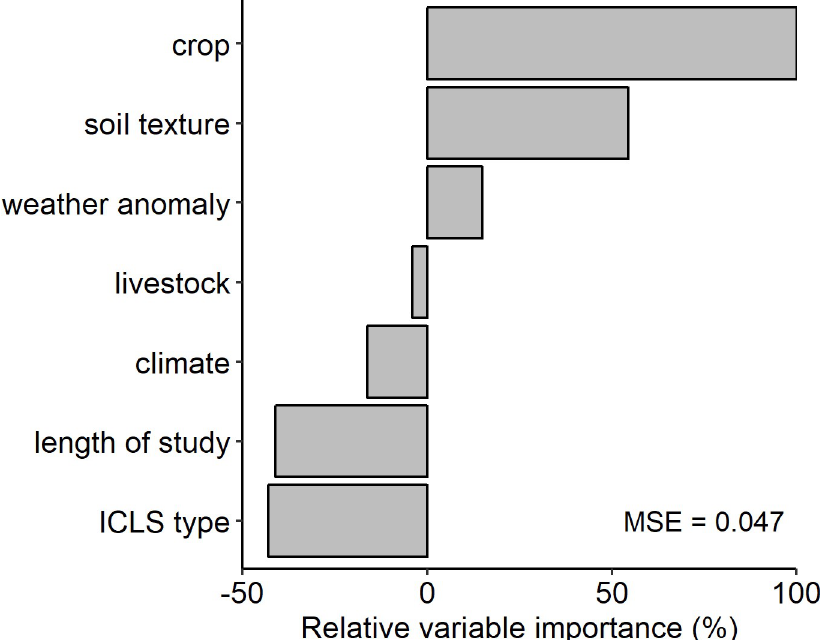
Fig 4. Relative variable importance ranking. Rankings were derived from a random forest permutation procedure, with the effect size of ICLS relative to unintegrated systems as the response variable. Model variables were ranked according to the percent increase in mean squared error (MSE, or out-of-bag error) when they were removed from the model (Type 1 classification) and normalized relative to the most important variable. Negative variable importance indicates variables that were no more informative to the model than random